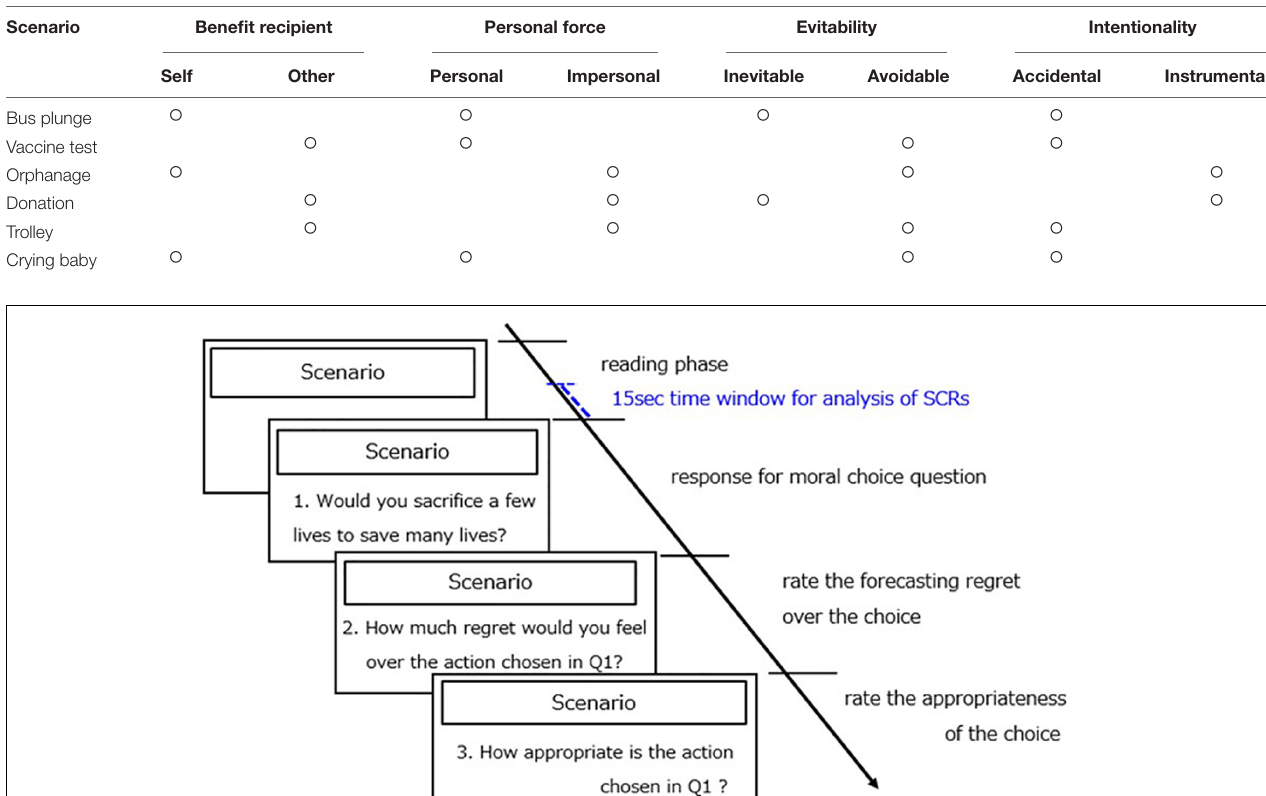
TABLE 1 | Each dilemma scenario included one of the two factors in each category: either self or other in the Benefit recipient category, personal or impersonal in the Personal force category, inevitable or avoidable in the Evitability category, and accidental or instrumental in the Intentionality category. Scenario